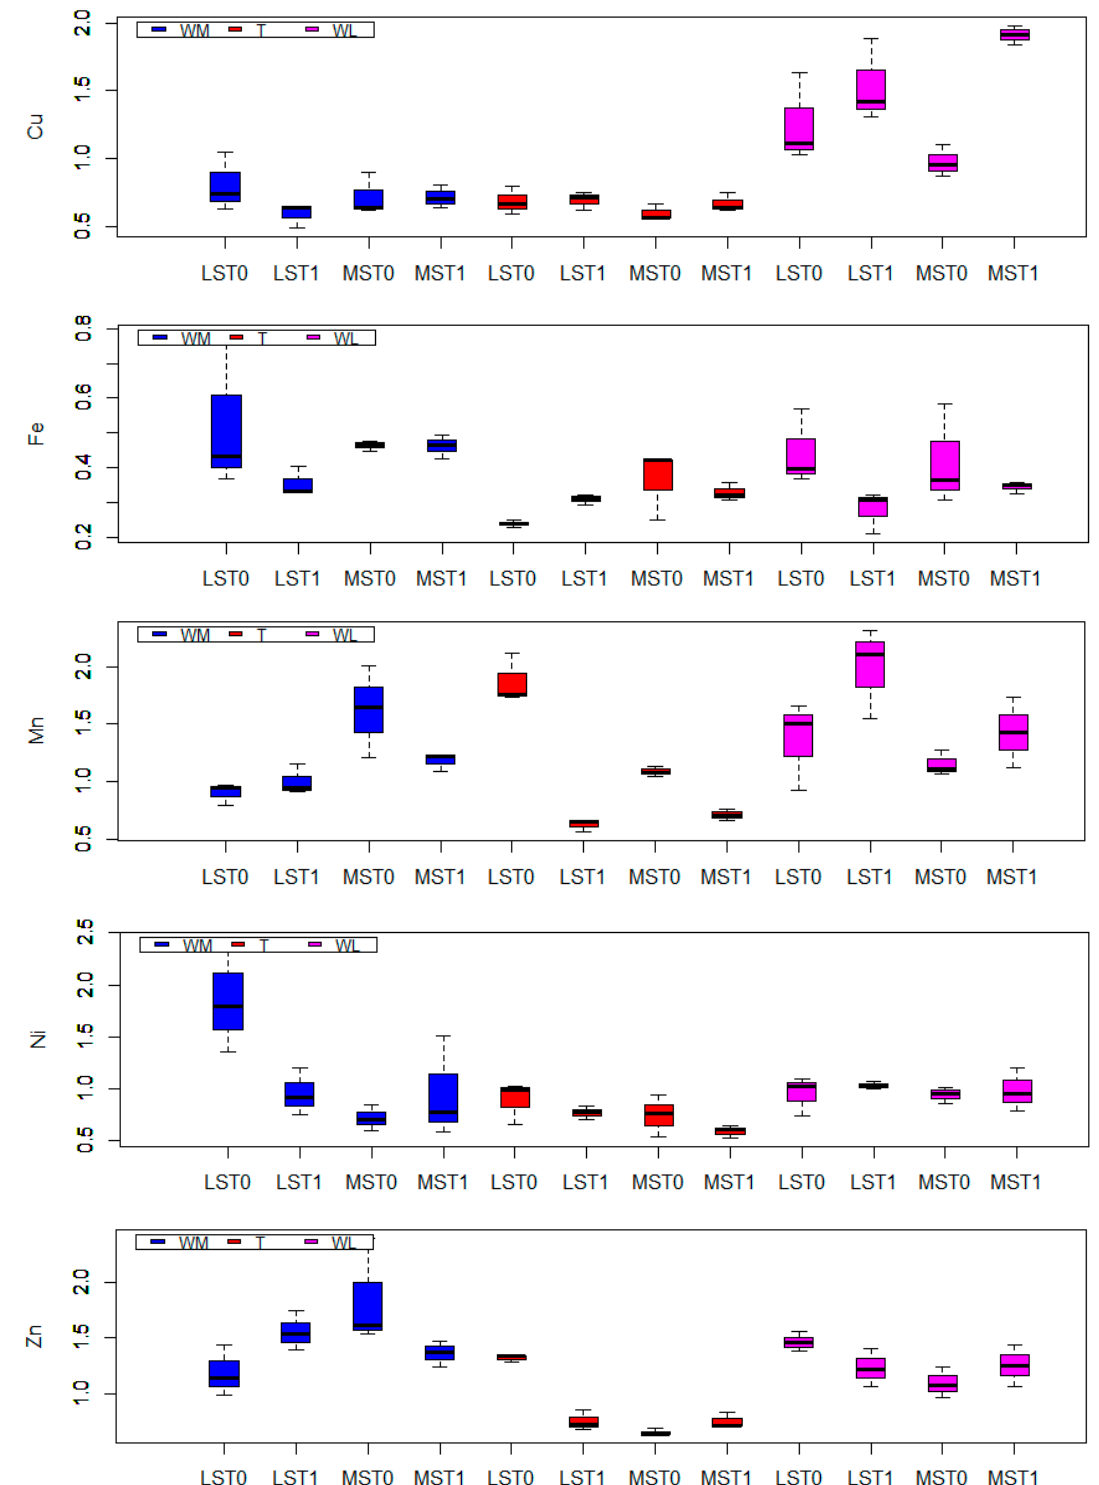
Figure 3. Harvest index (HI) values for plants (non-unit index). In the figure, the minimal value, first quartile (Q1), median, third quartile (Q3), and the maximal value are given to display the distribution of data. On the OX axis, the combination of treatments are marked, for more details see description in Material and Methods.